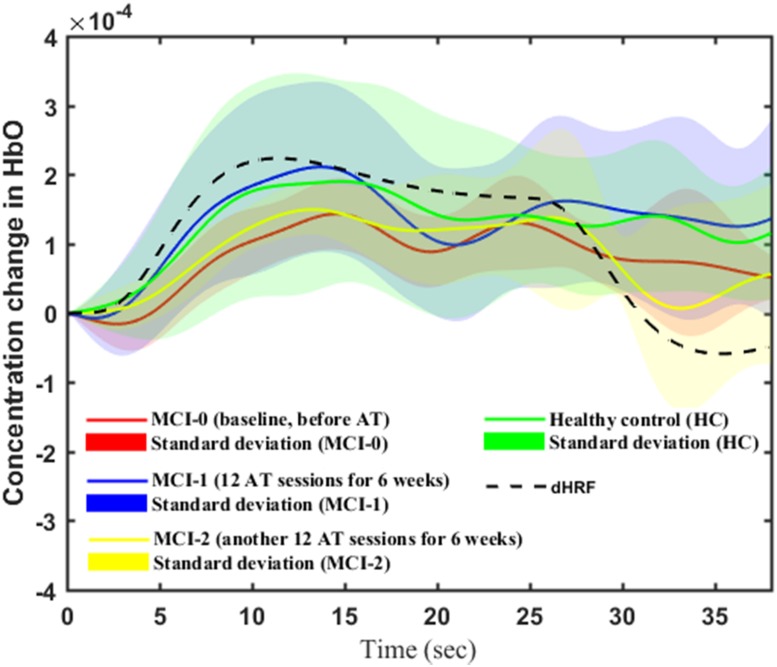
Averaged ΔHbOs (solid lines) and their standard deviations (shaded region) of HC, MCI-0, MCI-1, and MCI-2 (the dashed curve denotes the dHRF).